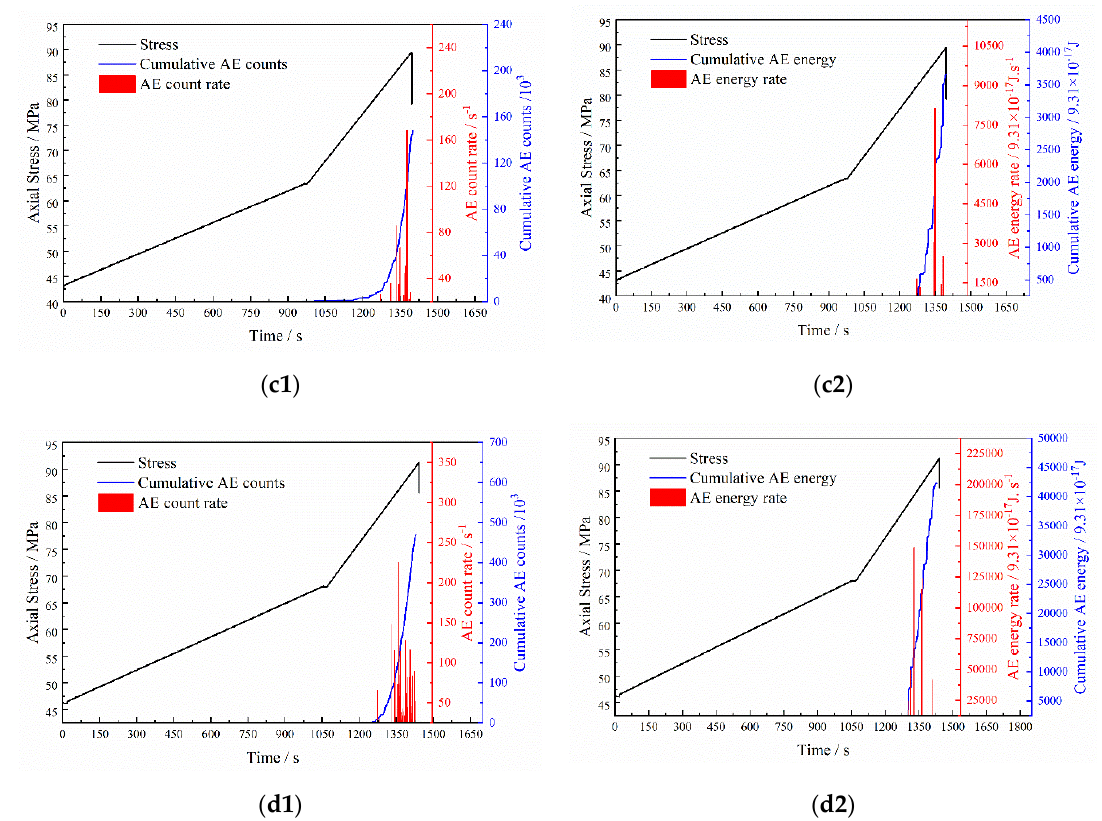
Figure 4. AE temporal characteristic parameter and deformation evolution process of coal samples at different depths: ( a1 ) 300 m (cumulative AE counts and AE count rate), ( a2 ) 300 m (cumulative AE energy and AE energy rate), ( b1 ) 600 m (cumulative AE counts and AE count rate), ( b2 ) 600 m (cumulative AE energy and AE energy rate), ( c1 ) 850 m (cumulative AE counts and AE count rate), ( c2 ) 850 m (cumulative AE energy and AE energy rate), ( d1 ) 1050 m (cumulative AE counts and AE count rate), and ( d2 ) 1050 m (cumulative AE energy and AE energy rate).